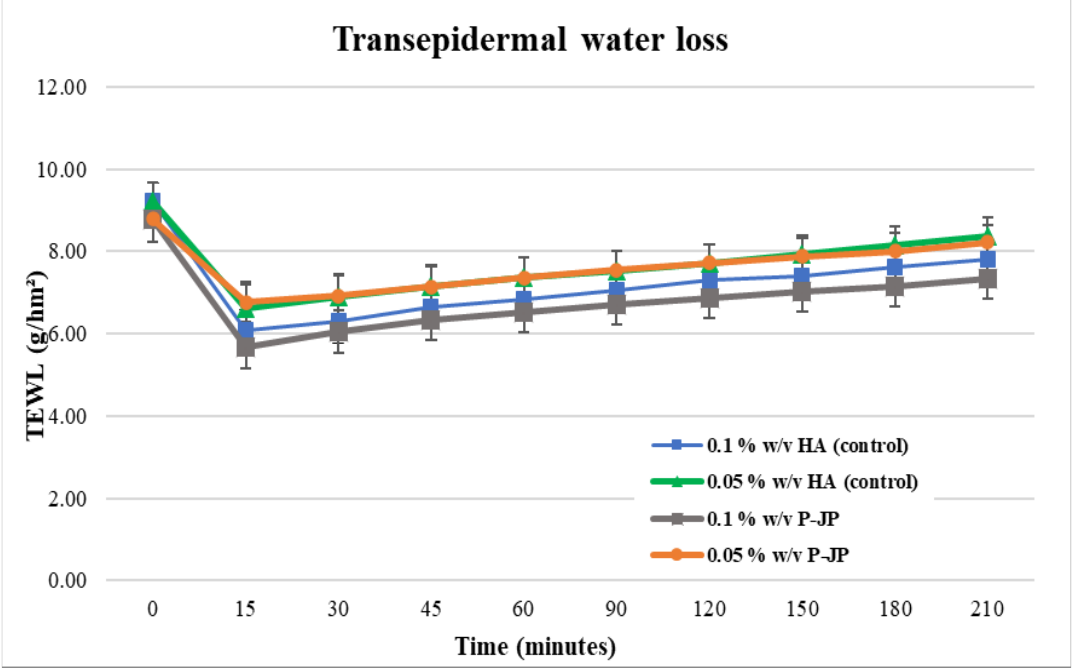
Figure 4. Transepidermal water loss of 0.05 and 0.1% w / v of the purified Japanese pumpkin polysac- charides (P-JP) in comparison with 0.05 and 0.1% w / v of hyaluronic acid (HA) evaluated for TEWL from 0–210